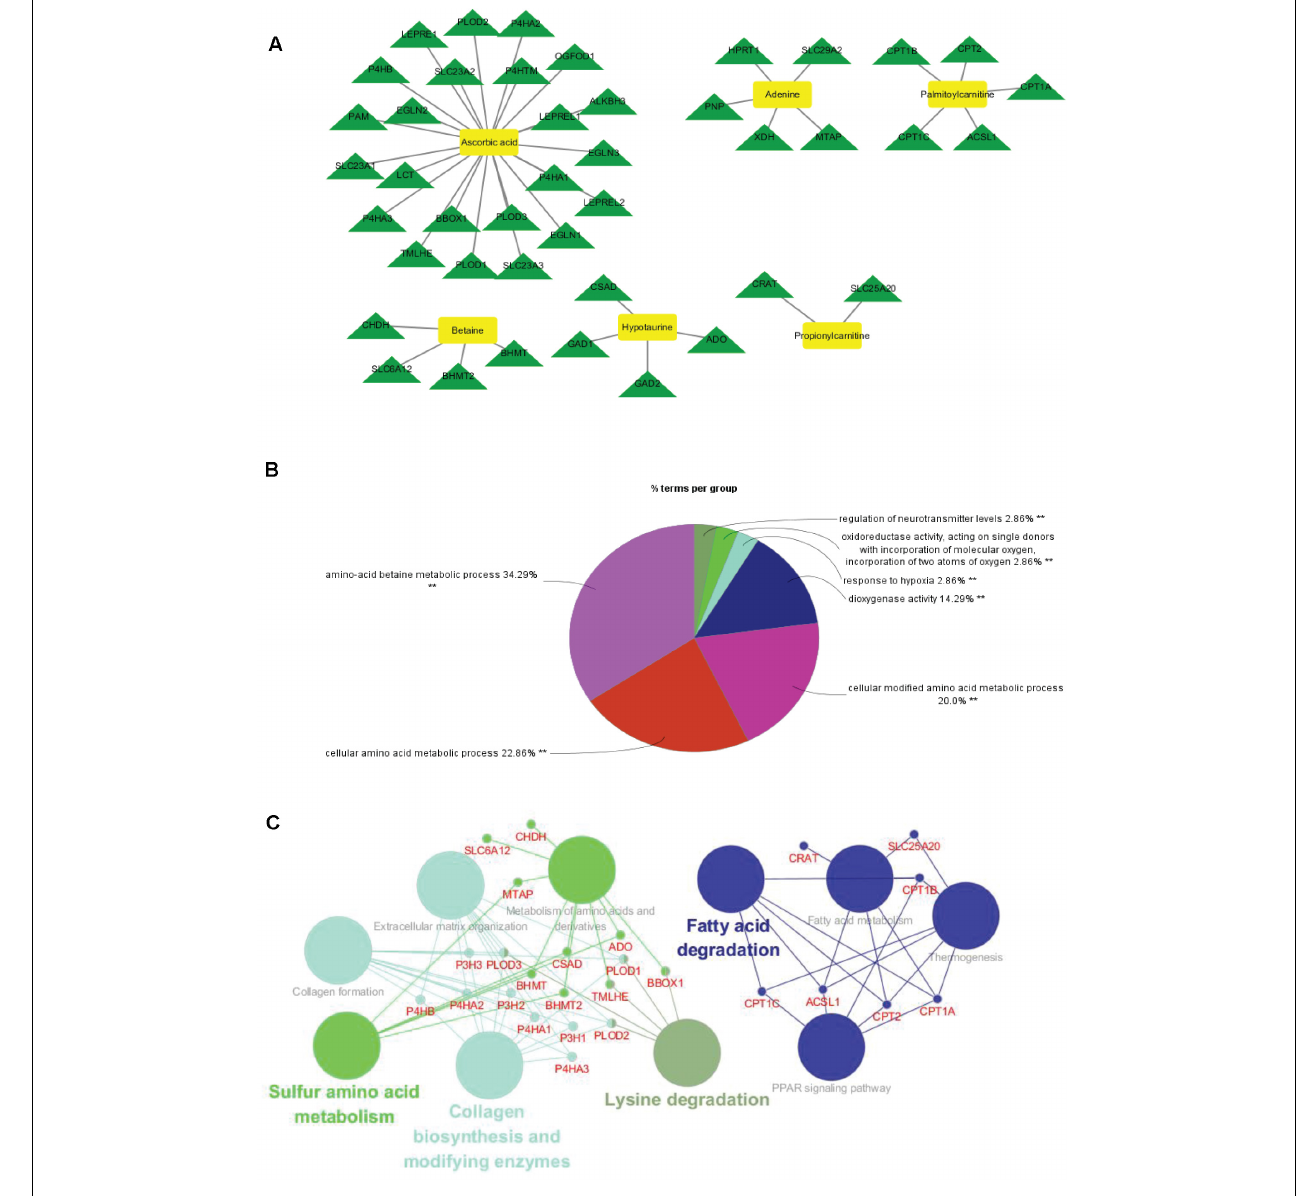
FIGURE 9 | Metabolite-related proteins identified from the database and their associated analysis were visualized by the Cytoscape tool. (A) Representative metabolite–protein interaction network of the hippocampus, extracted from the database following the subacute phase. The network was constructed with metabolite compounds (yellow and rectangle) and protein enzymes (green and triangle) as nodes. (B) A pie chart provides a visualization of the seven biological processes enriched by the proteins. (C) The protein pathway network provides a view of the functional relationships among